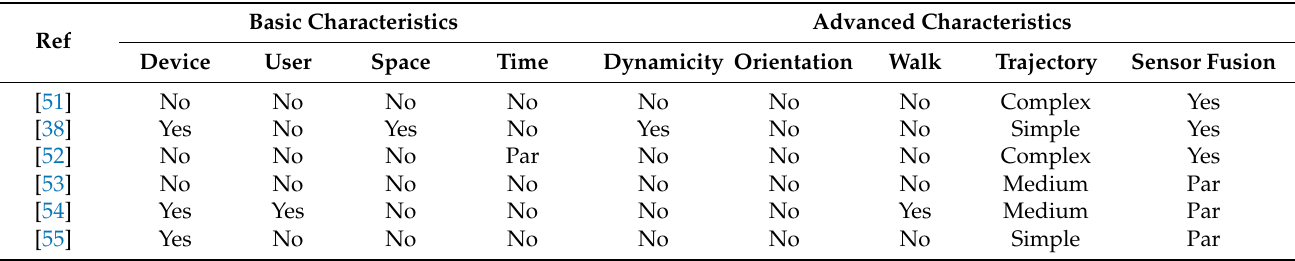
Table 1. Analysis of the available magnetic field benchmark